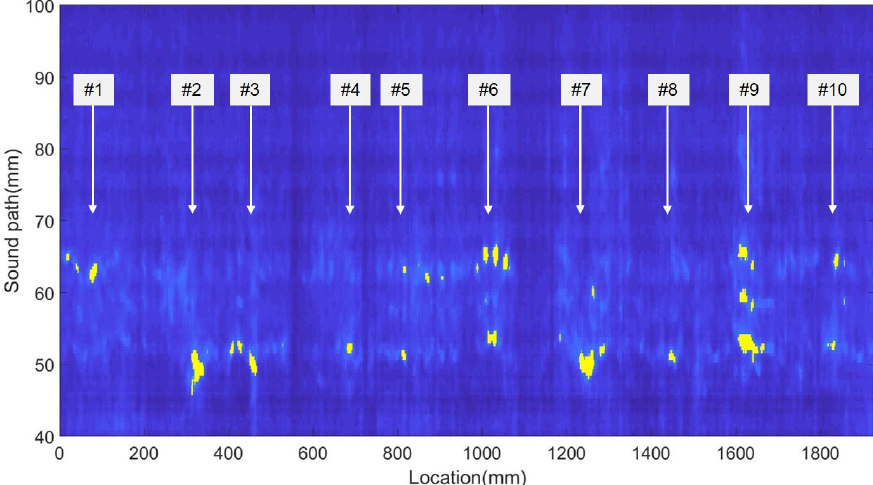
Figure 13. Internal defect detection signal map of the welding test